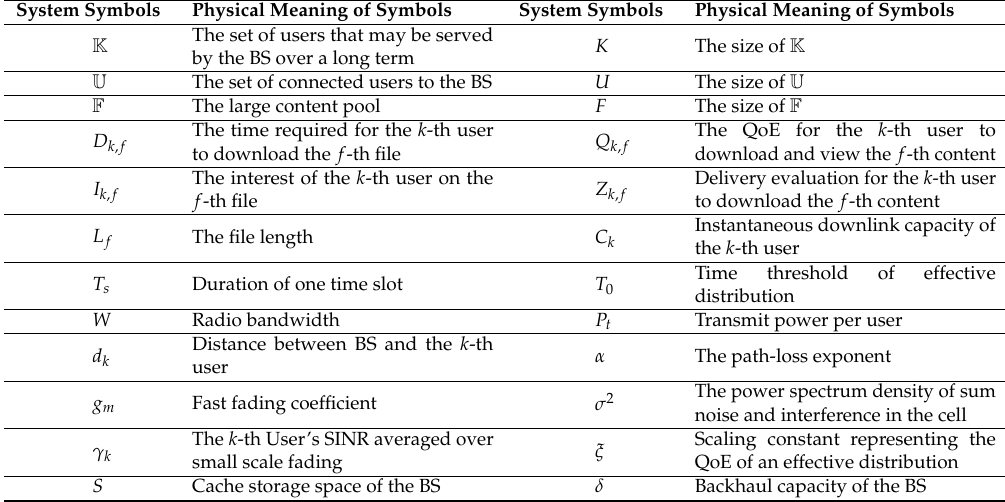
Table 1. Major system parameters and their physical